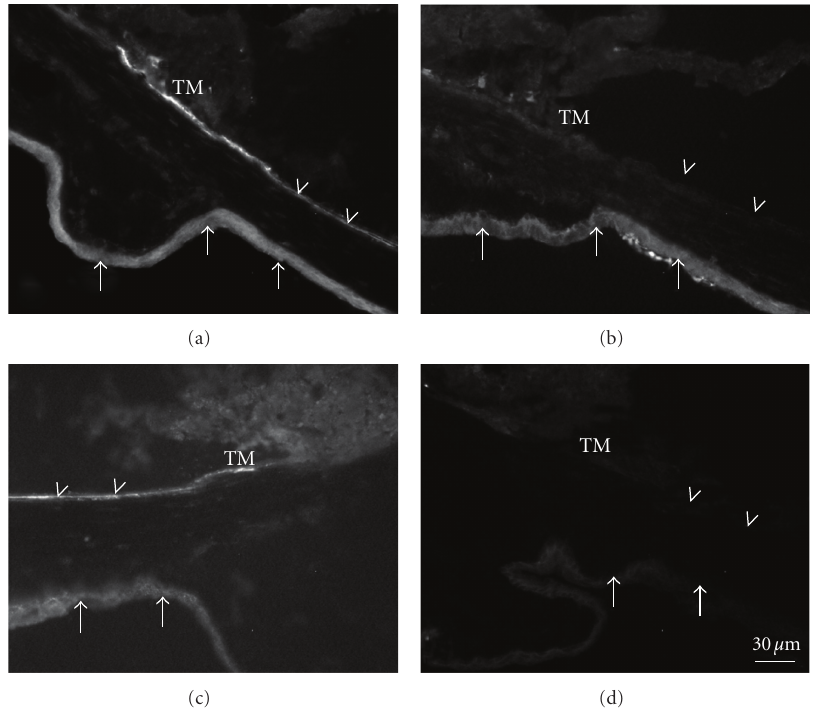
Figure 1: Immunohistochemical staining of the mouse anterior segment with antibodies against α -ENaC (a), β -ENaC (b), and γ -ENaC (c), immune sera were kindly provided by Bernard Rossier and Christoph Korbmacher, and without primary antibody (d). Note the intense staining of the trabecular meshwork (TM) and corneal endothelium (arrowheads) with α - and γ -ENaC, but not with β -ENaC. Arrows: conjunctiva and cornea epithelium. The conjunctiva did not show staining with antibodies against γ -ENaC (arrows in